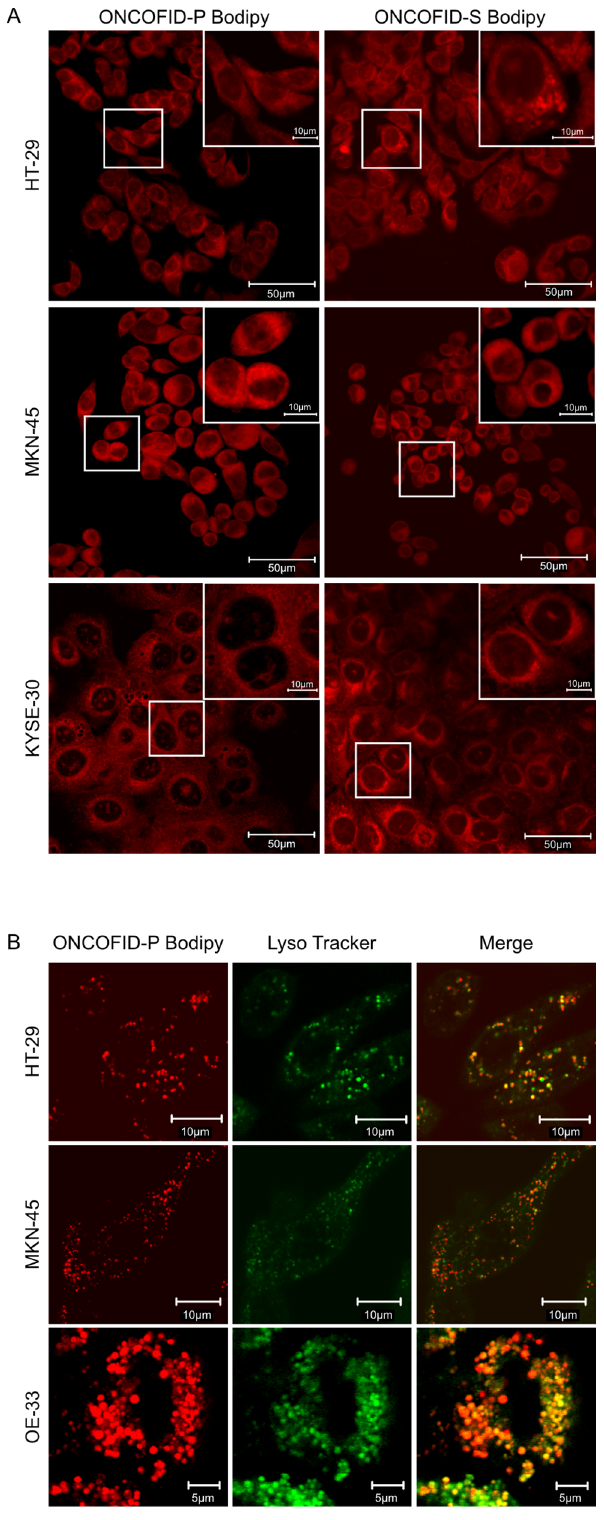
Figure 3. Confocal microscopy analysis and co-localization studies. A, accumulation of bioconjugates in HT-29, MKN-45 and KYSE- 30. Cells were incubated with BODIPY-labeled ONCOFID-P (50 m g/mL in paclitaxel equivalents) or ONCOFID-S (50 m g/mL in SN-38 equivalents) for 1 hour, washed and fixed before analysis. B, co-localization analysis of bioconjugates in lysosomes. HT-29, MKN-45 and OE-33 cells